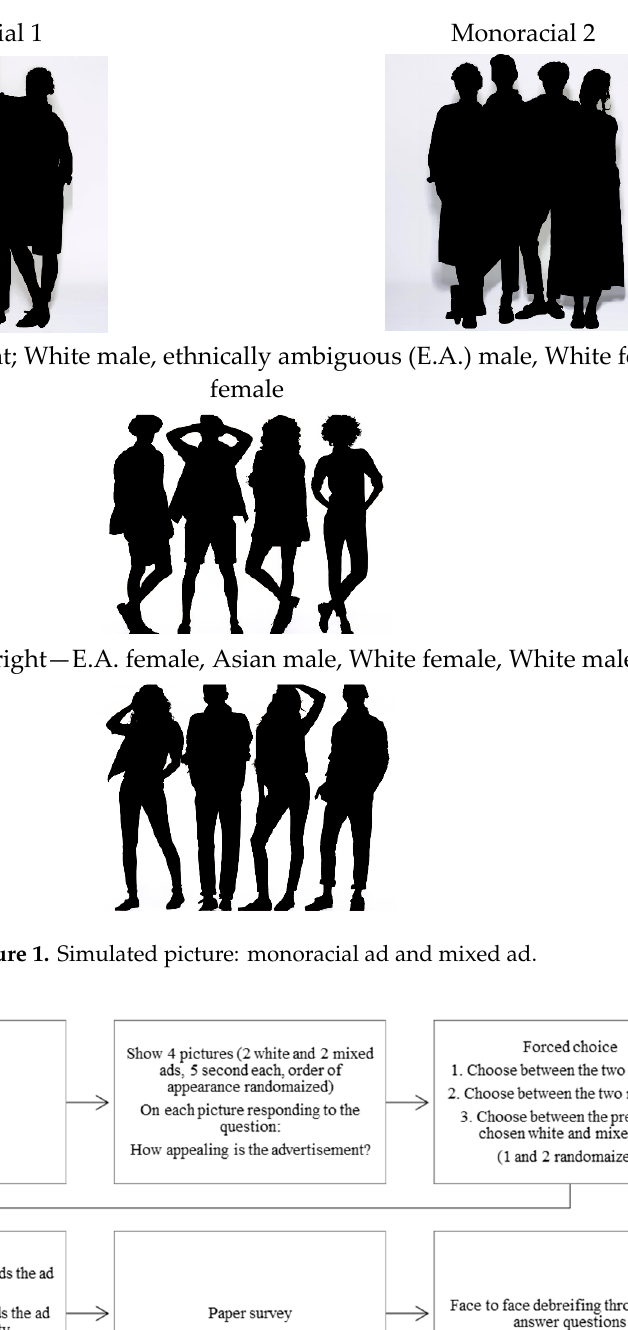
Table 1. Preference of advertisements.